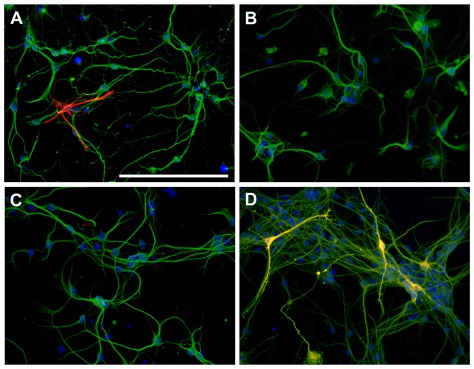
Cellular composition of neuron-enriched cultures.Composite fluorescence photomicrographs of neuron-enriched cultures that were immuno-stained with A–D) the neuronal marker MAP-2 (green) together with A) astrocyte marker GFAP (red) or B) the microglia marker CD11b (red, not detected) or C) the oligondendrocyte marker CNPase (red, not detected) or D) the dopaminergic neuron marker TH (yellow). Nuclei were counterstained with DAPI; scale bar length represents 100 µm.